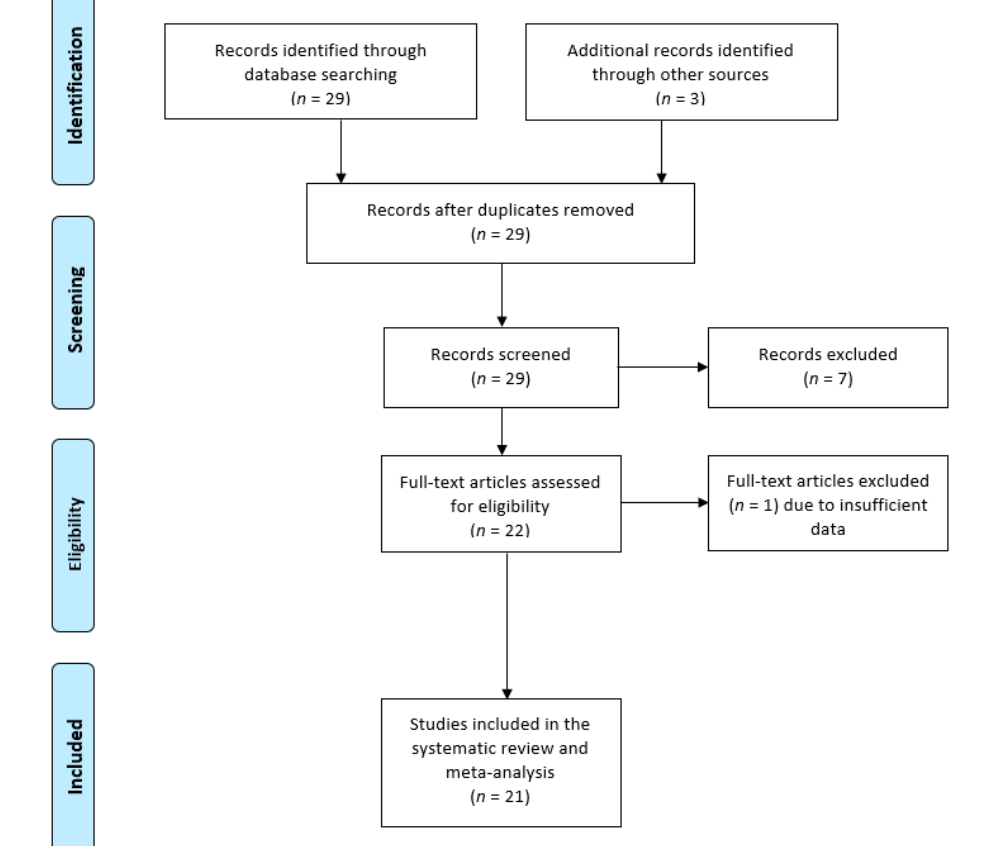
Figure 1. Flow chart of identified studies.